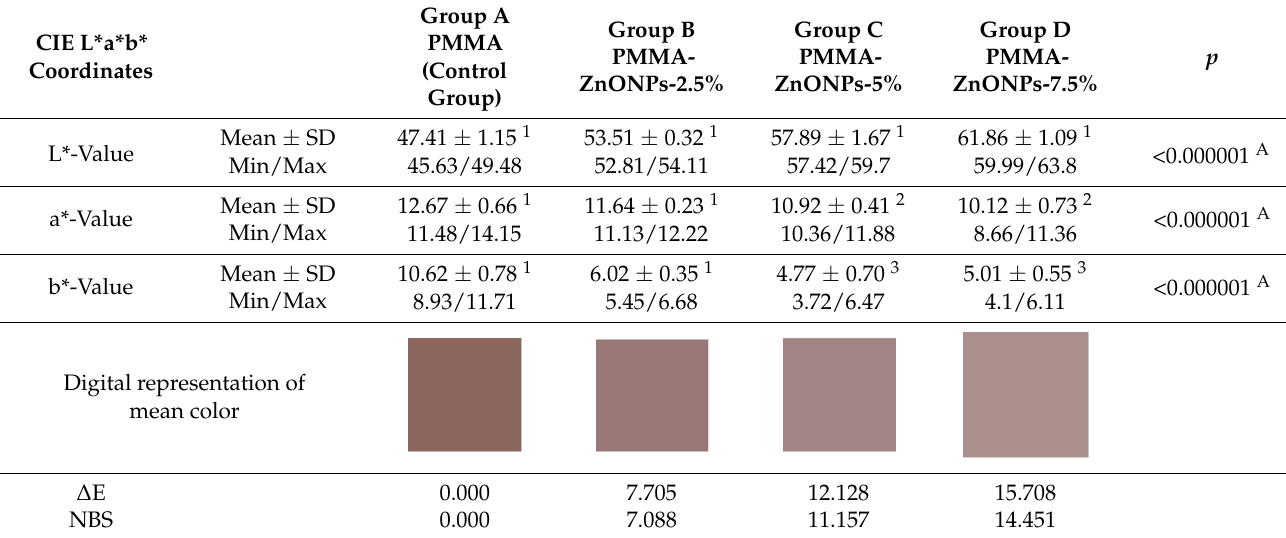
Table 1. Mean ± standard deviation of CIE L*a*b* values, ∆ E in relation to control group, NBS, and statistical data of PMMA samples with different ZnO NP content.